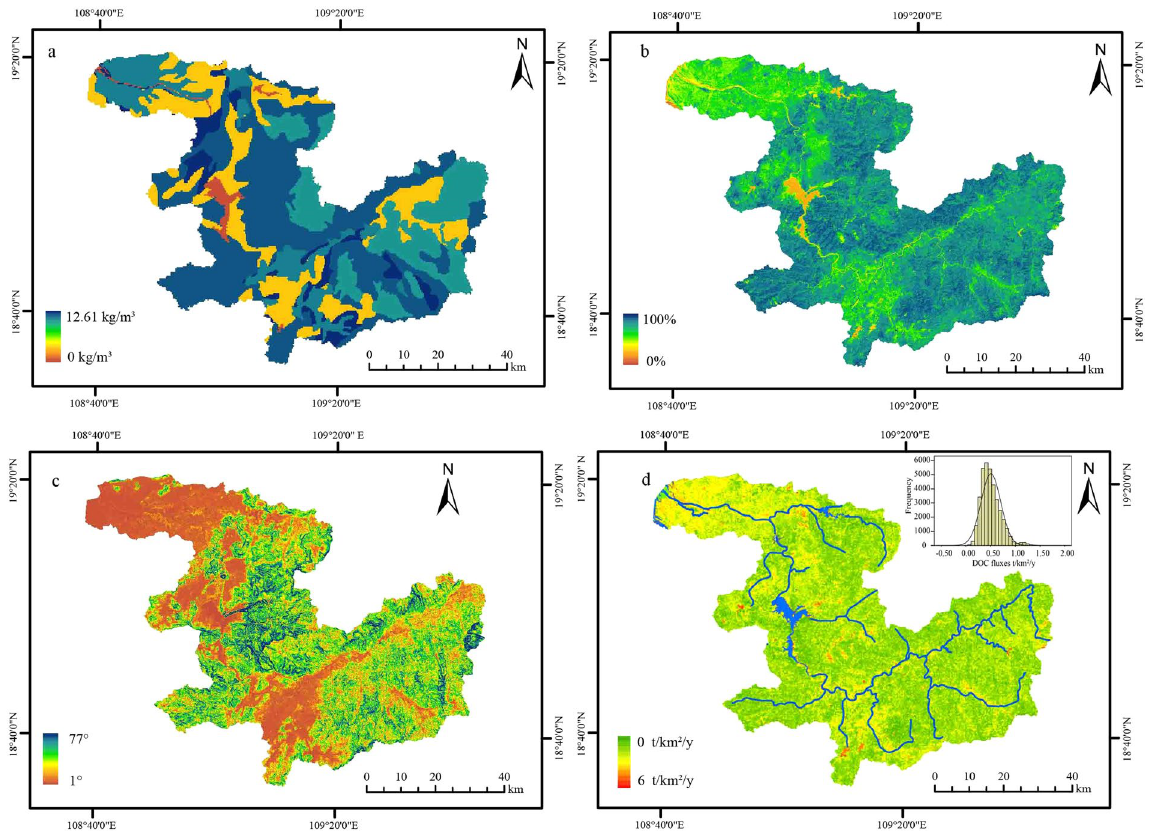
Figure 6. The soil organic carbon ( a ), slope ( b ), vegetation coverage ( c ) and simulated DOC fluxes ( d ) in CHJR basin (Analyzed by